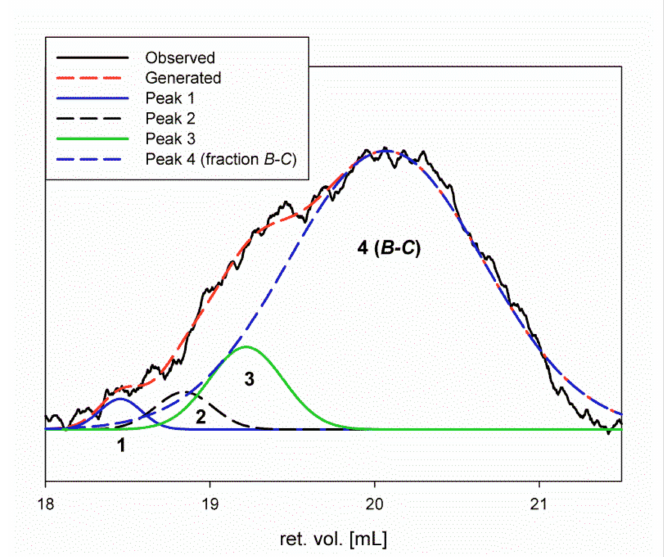
Figure 4. Deconvolution of the RI signal of product B - C .